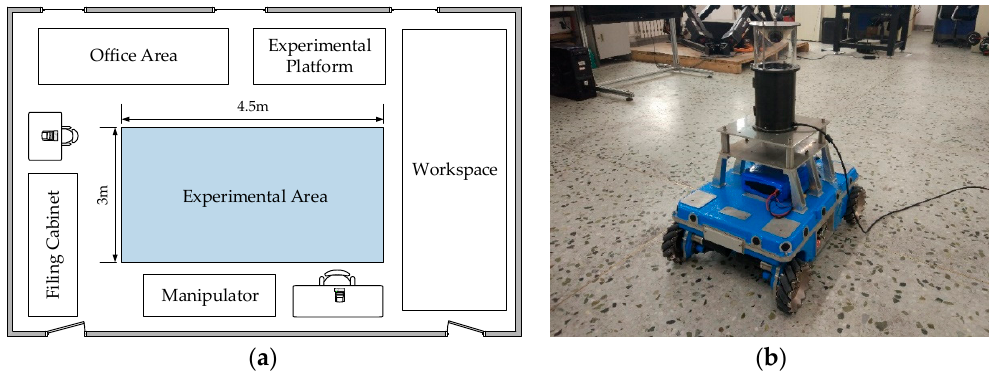
Figure 7. Experimental environment and mobile robot platform: ( a ) experimental environment, where the grey part denotes the experimental area; and ( b ) mobile robot platform.